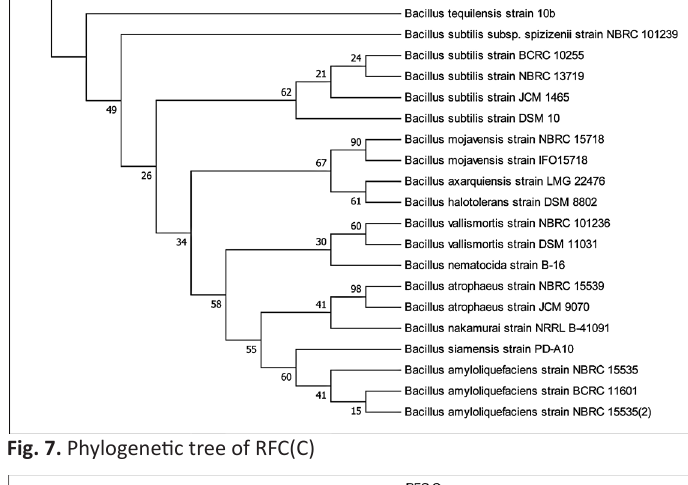
Fig. 7. Phylogenetic tree of